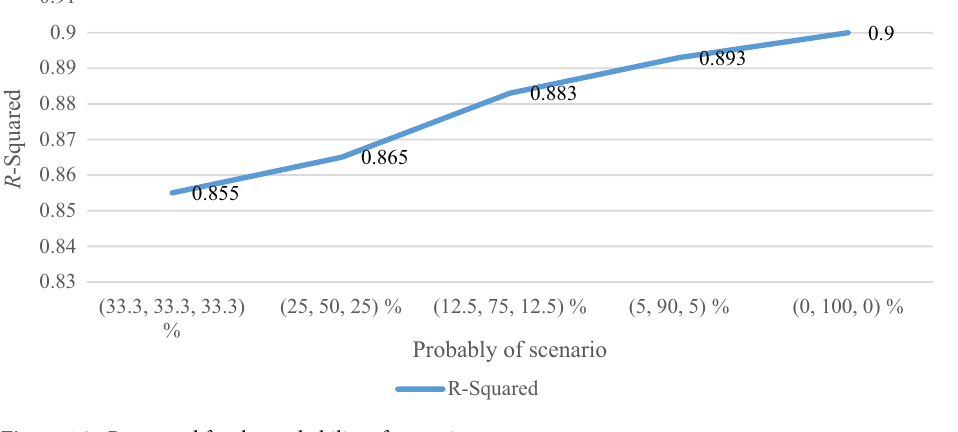
Figure 16. R-squared for the probability of